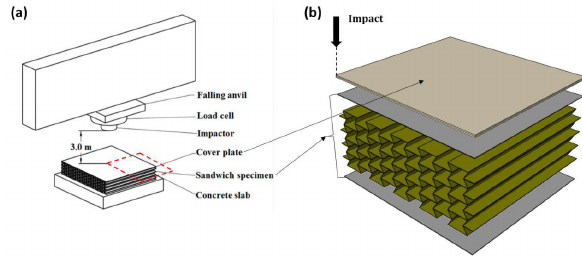
Figure 3: (a) Experimental setup [34]; (b) One quarter of finite ele- ment